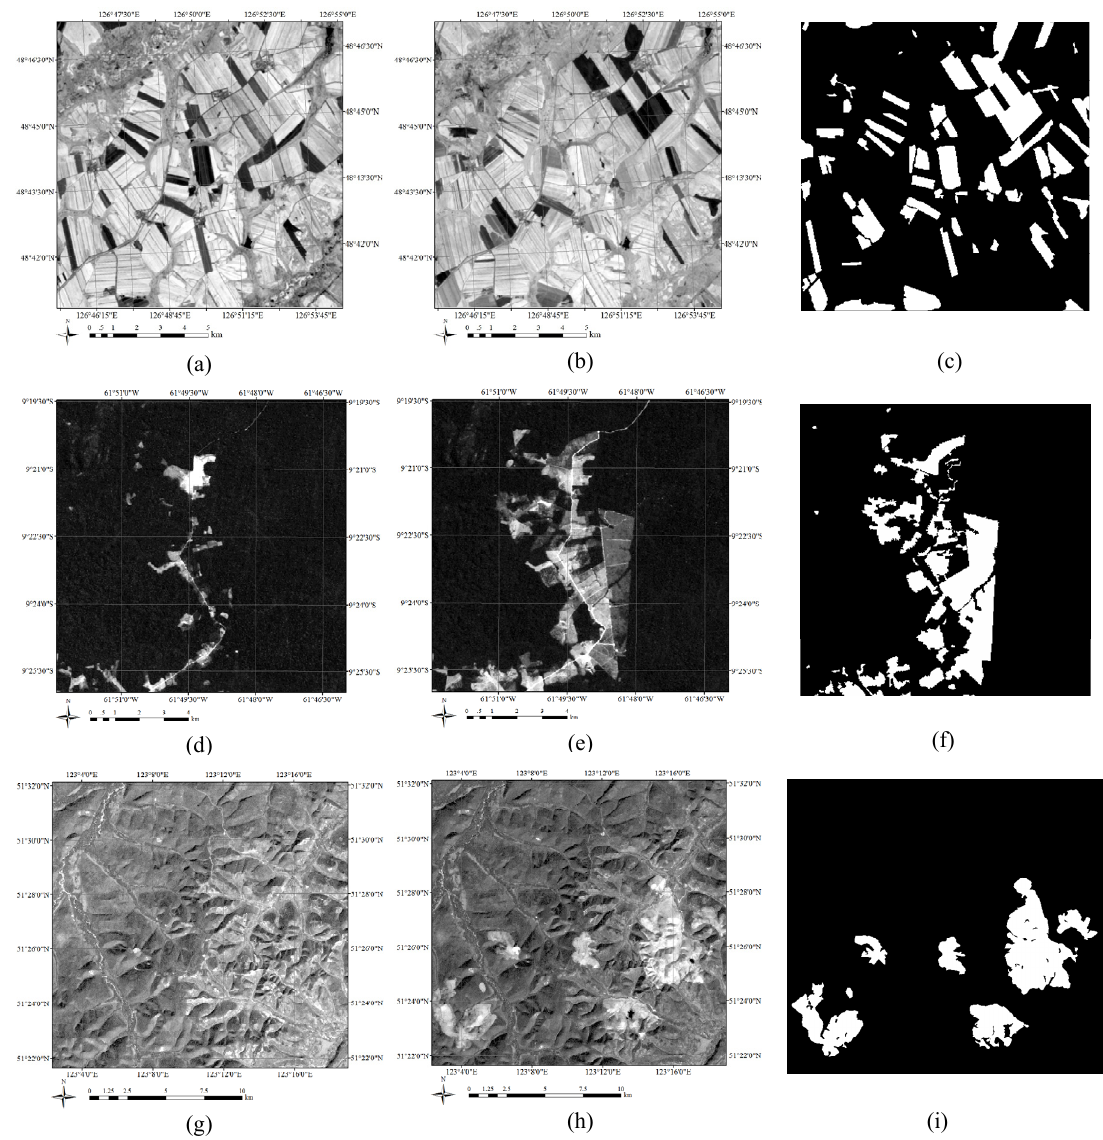
Figure 5. ( a ) Band 4 of image acquired in August 2001; ( b ) Band 4 of image acquired in August 2002; ( c ) Ground truth of ( a , b ); ( d ) Band 3 of image acquired in July 2000; ( e ) Band 3 of image acquired in July 2006; ( f ) Ground truth of ( d , e ); ( g ) Band 7 of image acquired in August 2007; ( h ) Band 7 of image acquired in August 2010; ( i ) Ground truth of ( g , h ).